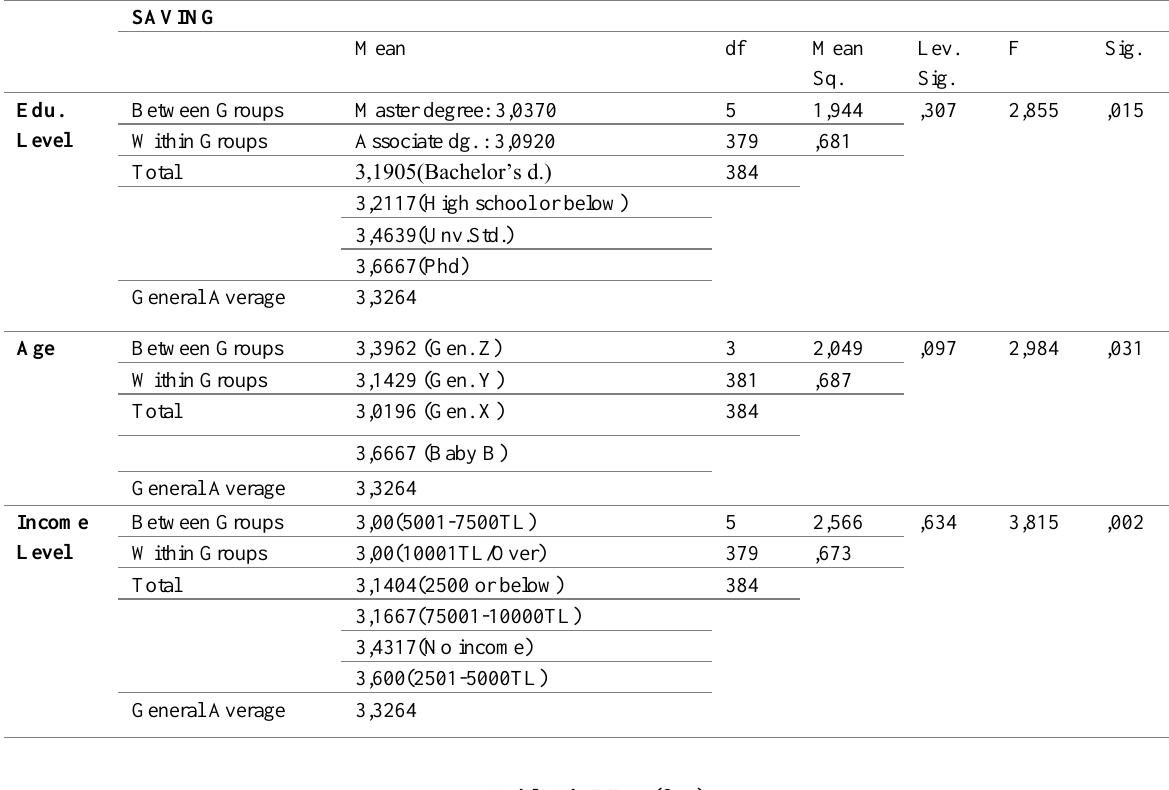
Table 5c: F Test (saving)